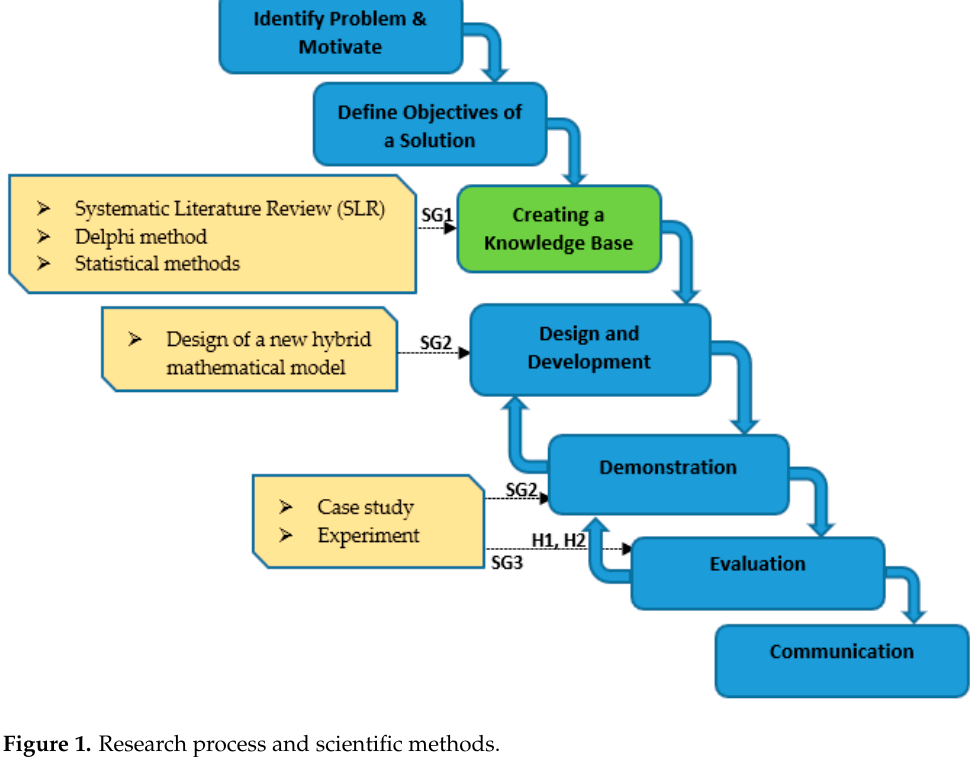
Figure 1. Research process and scientific